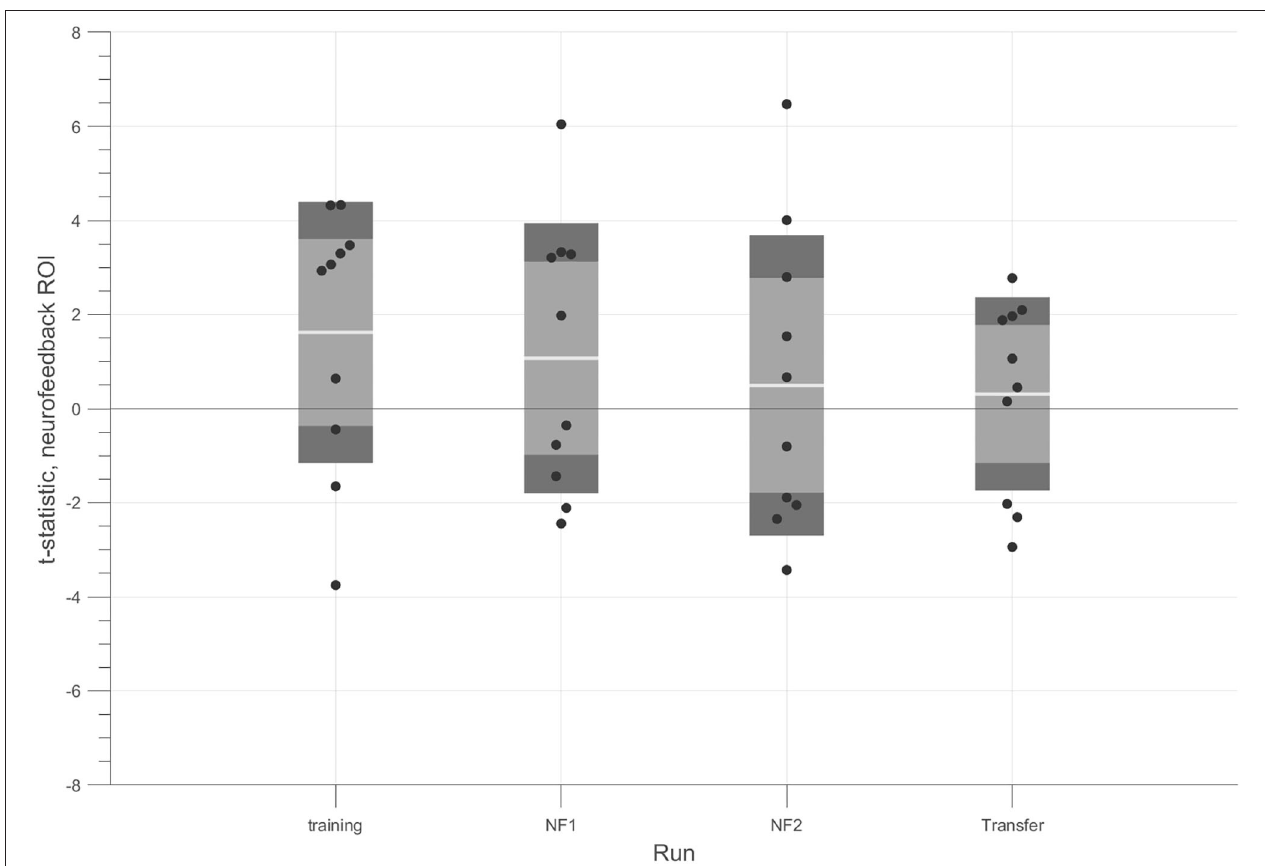
FIGURE 4 | t -tests for each run considering the contrast (4OMI + 2OMI) > SI within hMT + /V5 ROI. Black dots correspond to the t -statistic of each participant for the contrast of interest. The white line corresponds to the mean value across participants, the light gray area represents the standard error of the mean (mean ± SEM), and the dark gray regions correspond to the standard deviation (mean ±